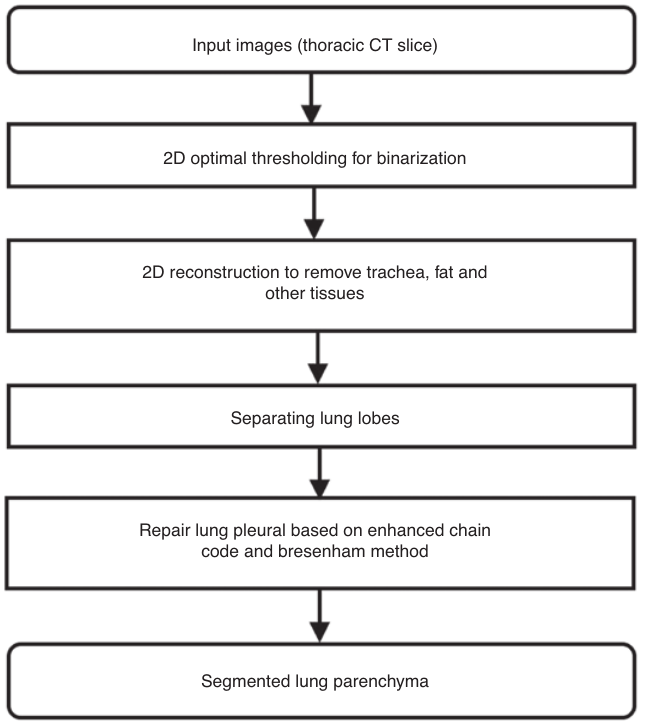
Figure 1: Flowchart of Automated Segmentation of Lung Parenchyma Using Break and Repair